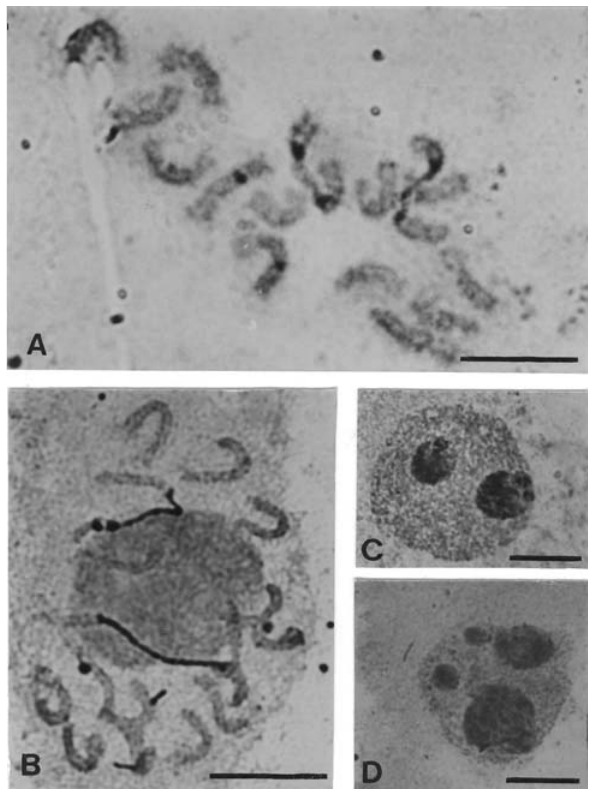
Figure 3 - Silver-stained mitotic chromosomes and interphase nuclei. Metaphase with chromosomes 1 (arrowheads) and 4 (arrows) showing positive signals (A). Prophase with chromosome pair 1 labelled and asso- ciated with the nucleolus, whereas chromosome 4 does not appear labeled (B). Interphase nuclei with two medium-size nucleoli (C) and four (two medium and two small) nucleoli